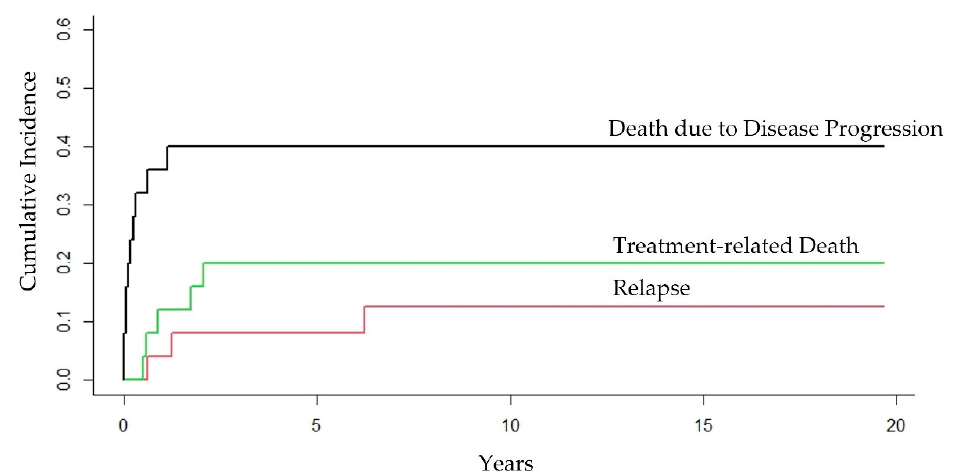
Figure 2. Cumulative incidence (competing risk model) for death due to disease progression/non- complete response, treatment-related death, and relapse over 20 years of evolution.